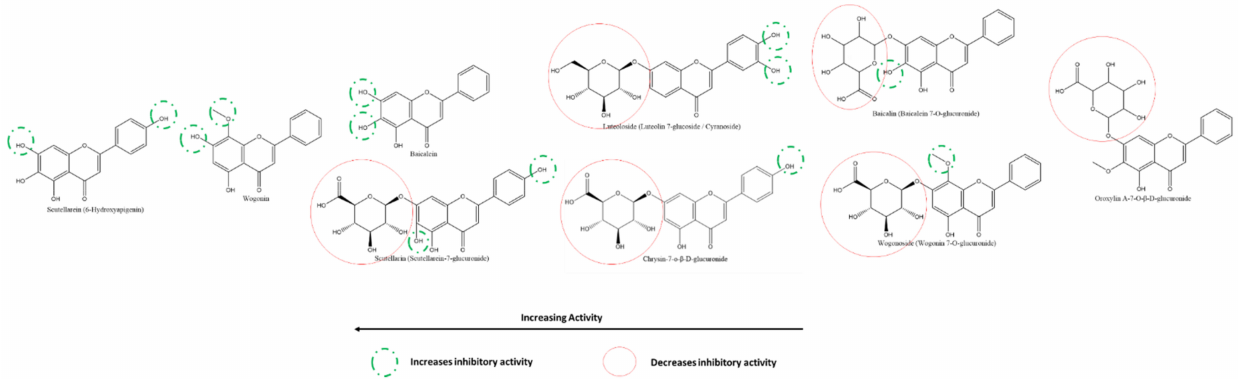
Figure 17. Structure–activity relationships of various flavones against SARS-CoV-2 PLpro, adapted from the experiments of [126] using cell-based in vitro FRET assays. Substitutions and groups that result in an increase/decrease in inhibitory activities are shown in red and green,